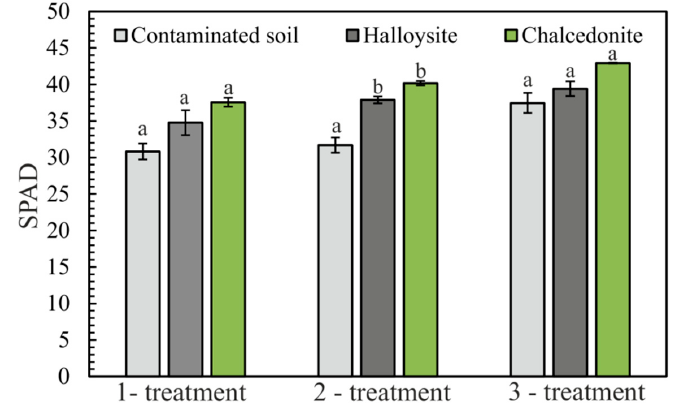
Figure 7. Chlorophyll a fluorescence—the Fv/Fm ratio. Different letters above the columns indicated significant difference at the p < 0.05.